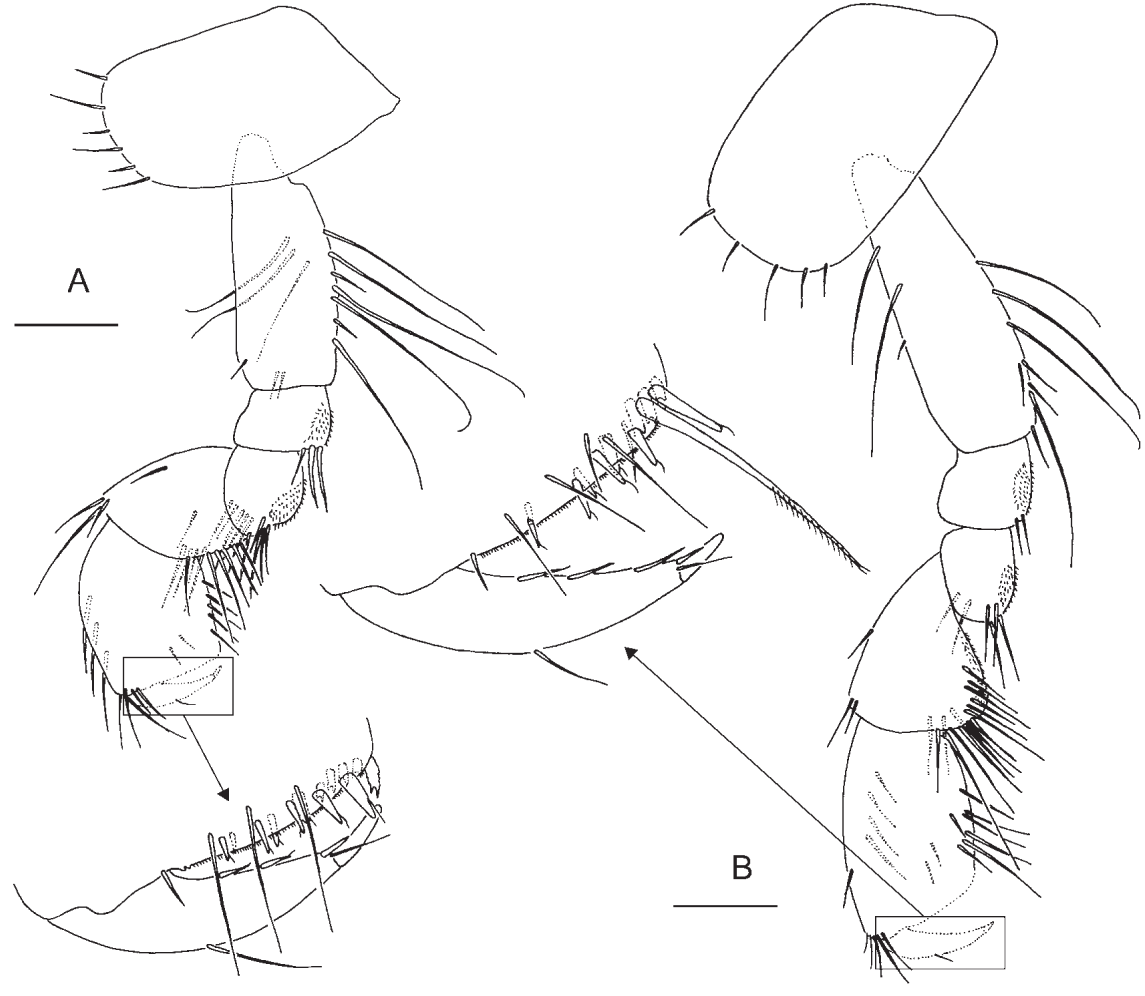
Fig. 7A-B. Synurella ambulans (F. Müller, 1846), ♀, 4.0 mm, FENU X34906/Cr-1406, KF. A . Gnathopod 1. B . Gnathopod 2. Scale bars 0.2